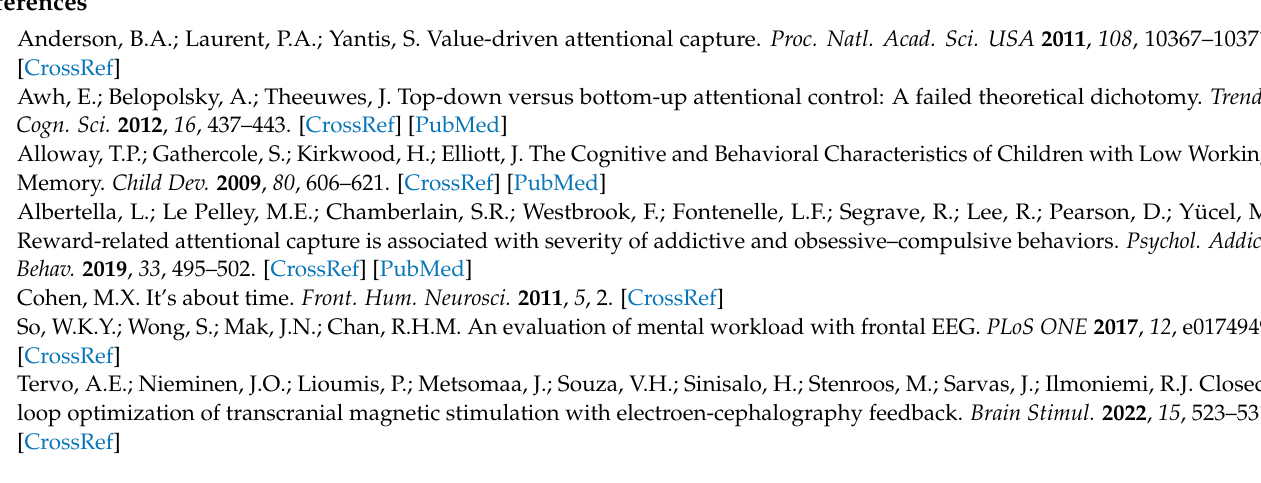
5000 iterations. Figure S12: Participant 12 predictions for each model are overlaid on top of the normalized RT. For the linear model, the shaded bounds represent the 95% confidence intervals generated by the GLM. For the neural network model, the shaded bounds represent one standard deviation over the 5000 iterations. Figure S13: Participant 13 predictions for each model are overlaid on top of the normalized RT. For the linear model, the shaded bounds represent the 95% confidence intervals generated by the GLM. For the neural network model, the shaded bounds represent one standard deviation over the 5000 iterations. Figure S14: Participant 14 predictions for each model are overlaid on top of the normalized RT. For the linear model, the shaded bounds represent the 95% confidence intervals generated by the GLM. For the neural network model, the shaded bounds represent one standard deviation over the 5000 iterations. Figure S15: Participant 15 predictions for each model are overlaid on top of the normalized RT. For the linear model, the shaded bounds represent the 95% confidence intervals generated by the GLM. For the neural network model, the shaded bounds represent one standard deviation over the 5000 iterations. Figure S16: Participant 16 fitted predictions for each model are overlaid on top of the normalized RT. For the linear model, the shaded bounds represent the 95% confidence intervals generated by the GLM. For the neural network model, the shaded bounds represent one standard deviation over the 5000 iterations.